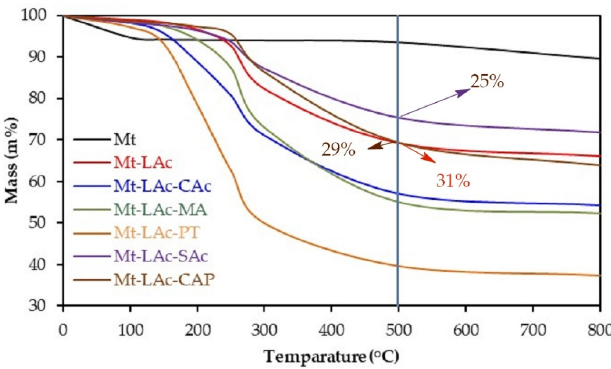
Figure 3. Mass loss as a function of temperature for modified Mt samples.